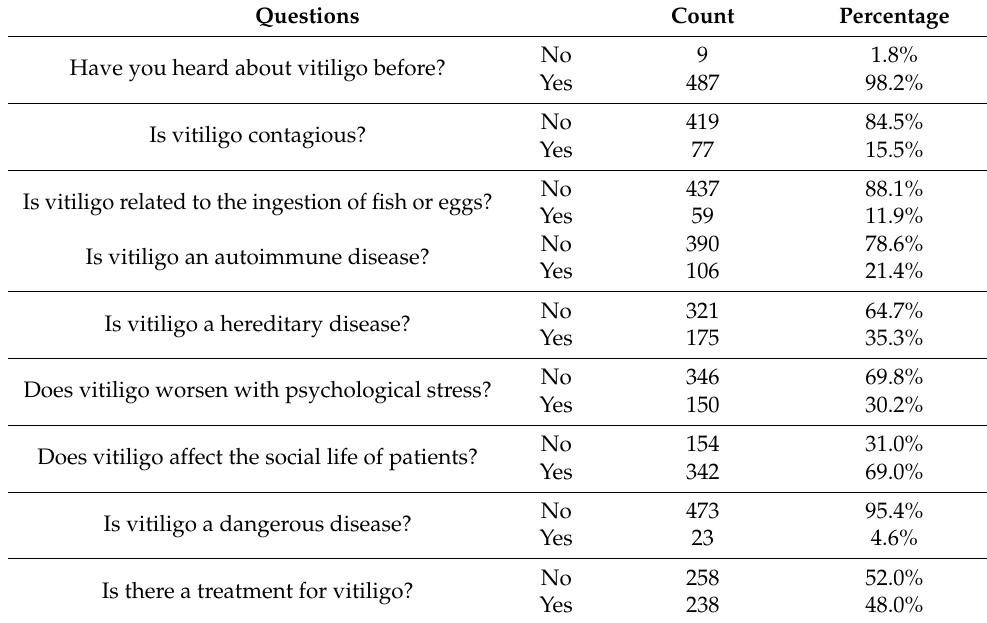
Table 2. Participants’ responses to questions regarding the knowledge of vitiligo.